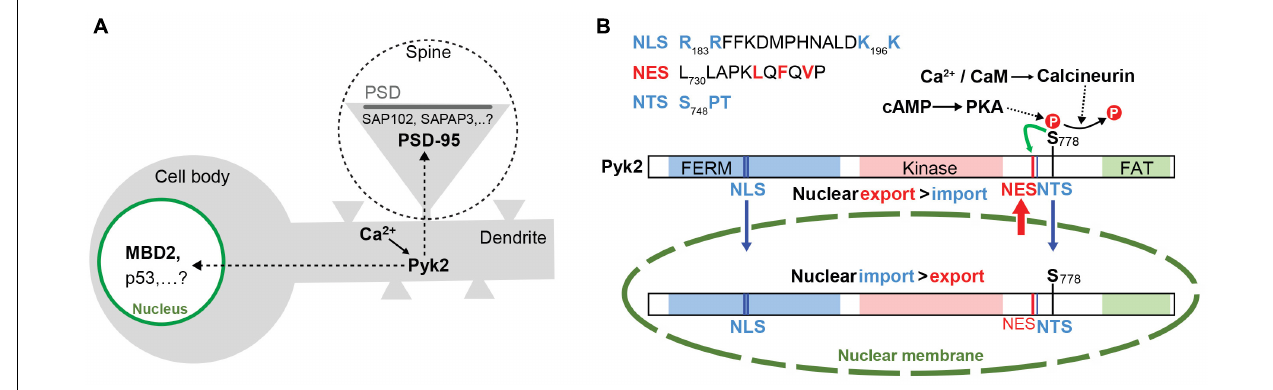
FIGURE 3 | Dynamic changes in Pyk2 localization in neurons. (A) In the absence of stimulus Pyk2 is mostly localized in the cytoplasm. In response to Ca 2 + influx (e.g., following depolarization or NMDAR stimulation), Pyk2 accumulates in the nucleus where it can interact with partners identified in non-neuronal cells (MBD2, p53) and in postsynaptic densities (PSDs) in dendritic spines (one is magnified in the dotted circle), where it can bind to PSD-95, SAP102 or SAPAP3 (see text for references and Figure 4 ). (B) Summary of the cytonuclear fluxes of Pyk2. Identified motifs in Pyk2 sequence known to be a nuclear export sequence (NES), a nuclear targeting sequence (NTS), and a nuclear localization signal (NLS). The localization of Pyk2 depends on the difference between its nuclear import and export rates. The nuclear import results from the interaction of NLS and NTS with specific carriers for transport through the nuclear pores (symbolized as an interruption in the nuclear membrane). The nuclear export depends on the activity of the NES motif that is potentiated by phosphorylation of Ser778 ( S 778 ). Dephosphorylation of S